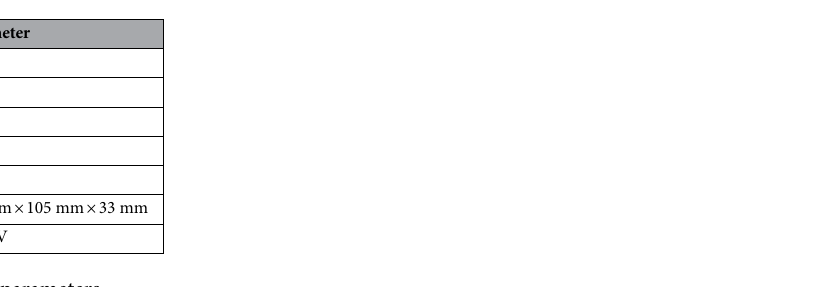
Table 1. Technical